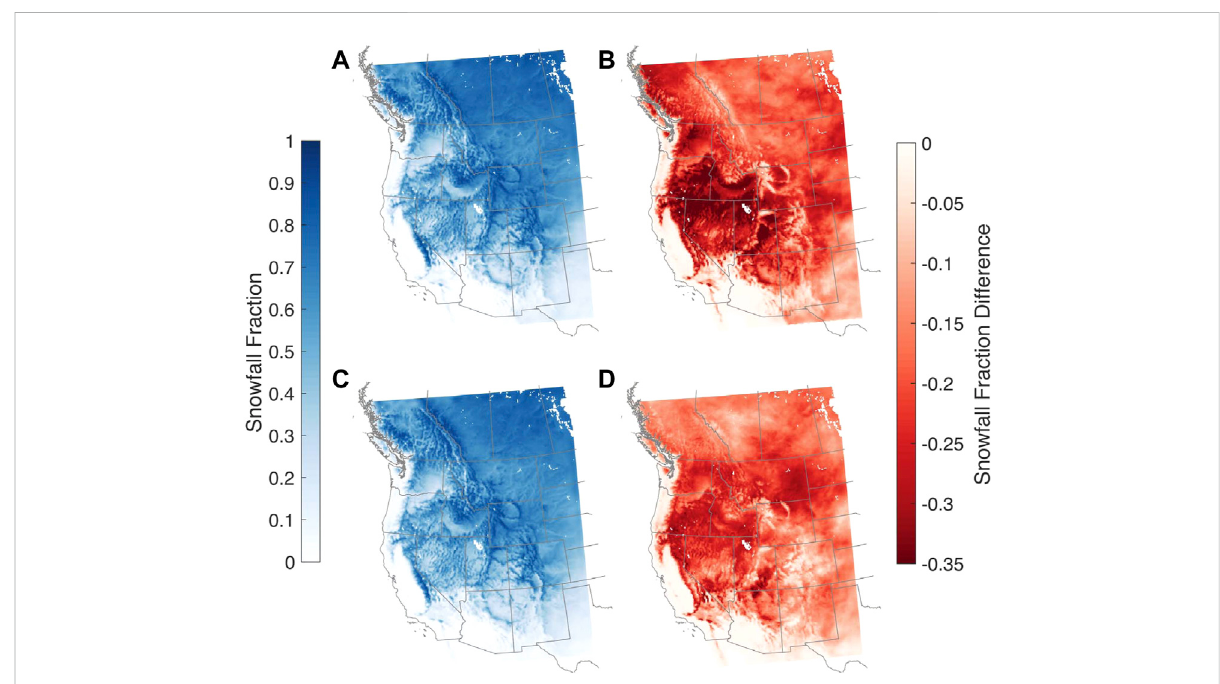
FIGURE 5 As for Figure 4 but for snowfall fraction. (A,B) are for WRF/CCSM and (C,D) are for